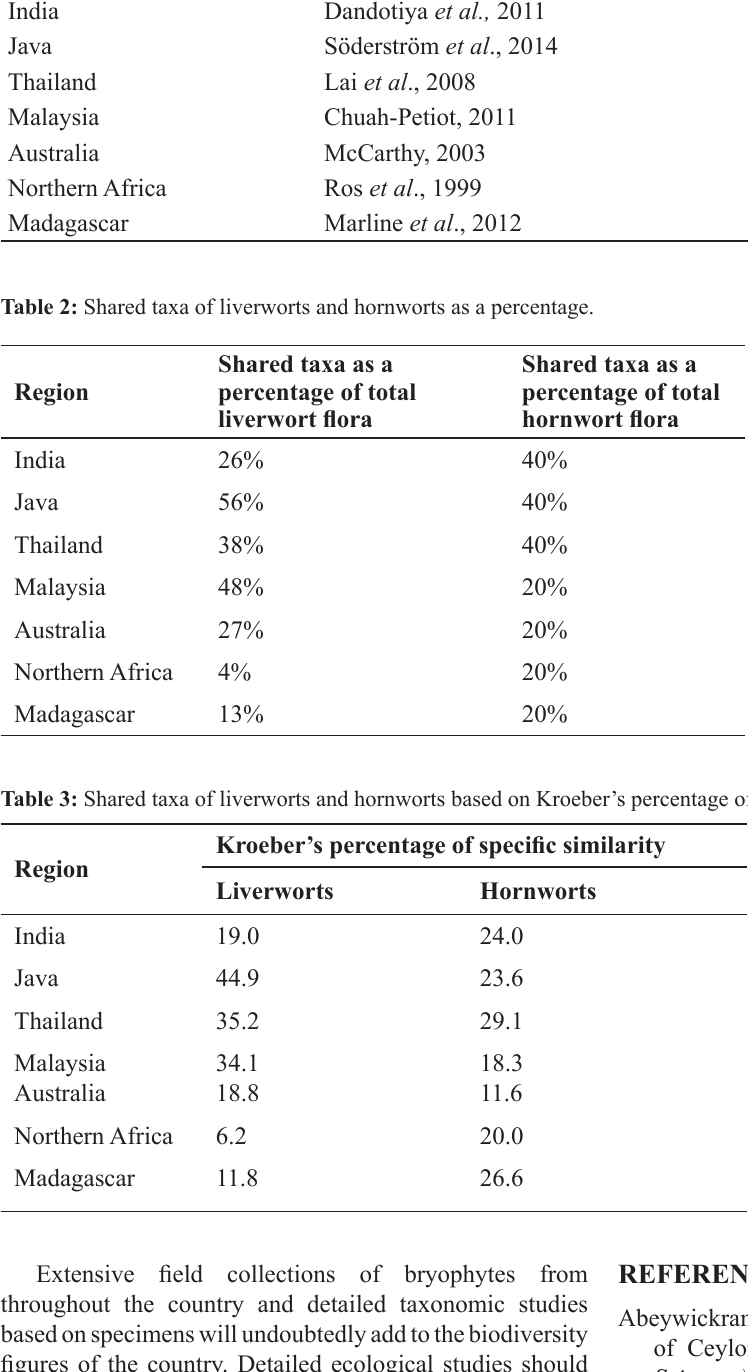
Table 1: Published checklist sources used in the analysis.